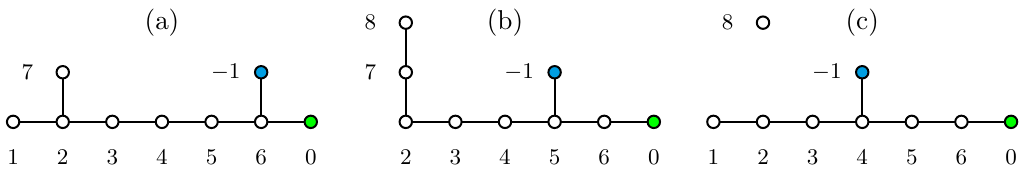
Figure 10. Three extra subdiagrams which do not come from a two-step shift-vector construction. They can be inferred from the right side of (cid:12)gure